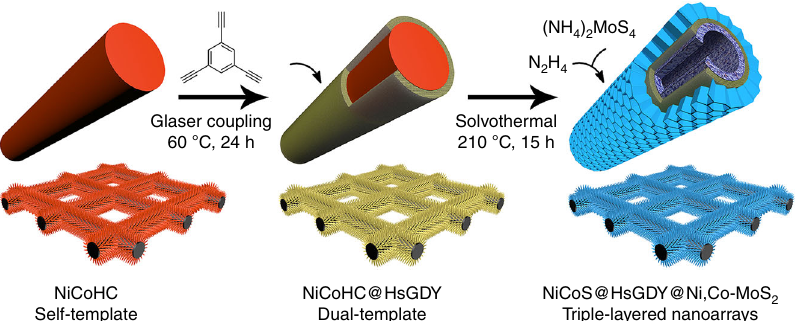
Fig. 1 Schematic illustration of the fabrication of triple-layered nanotube arrays. The chemical synthesis of hierarchical triple-layered NiCoS@HsGDY@Ni, Co-MoS 2 nanoarray comprised of Ni 3 S 2 /Co 9 S 8 inner layer (NiCoS), hydrogen-substituted graphdiyne (HsGDY), and Ni-,Co-co-doped MoS 2 (Ni,Co-MoS 2 ) is achieved with a HsGDY-coated